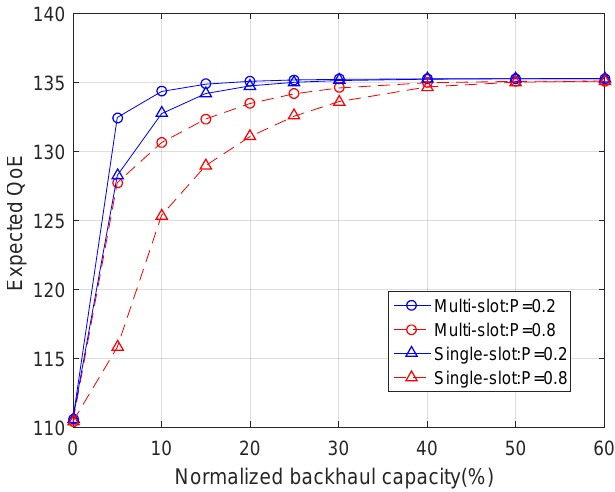
Figure 6. The expected QoE as a function of the normalized backhaul capacity, with varying user mobility and number of time slots.